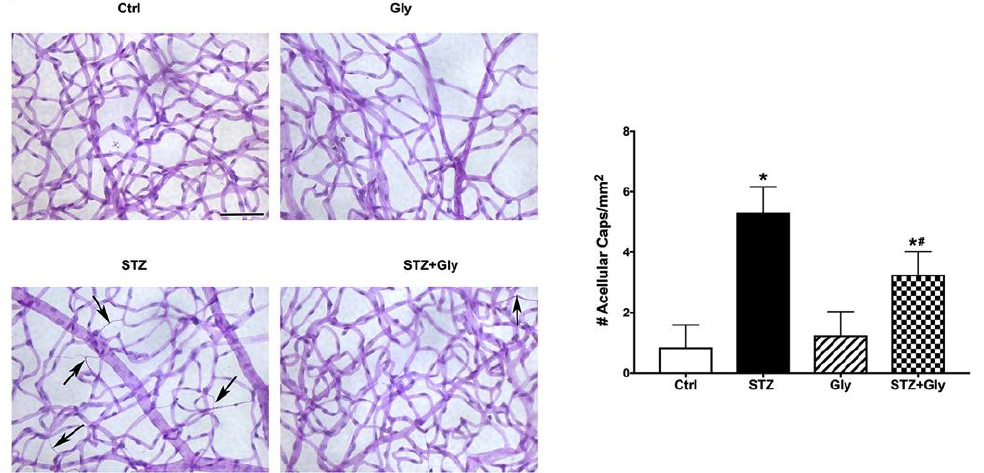
Figure 3. Vascular changes in the diabetic retina. Measurement of degenerate capillaries from control mice (Ctrl), control mice treated with glycyrrhizin (Gly), diabetic mice (STZ), and diabetic mice treated with glycyrrhizin (STZ + Gly). Representative images are presented on the left, with quantification on the right. Arrows point to degenerate capillaries. * p < 0.05 vs. ctrl, # p < 0.05 vs. diabetes. n = 5 for each group. Scale bar is 50 µm.